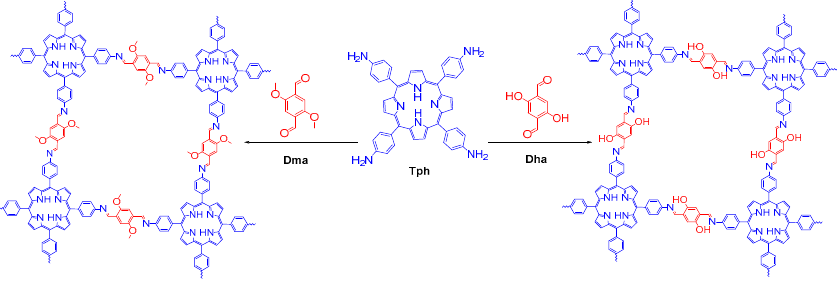
Figure 11. Syntheses of DmaTph and DhaTph by the condensation of square planar Tph building unit (blue) and linear Dma/Dha building unit (red). The introducing of -OH to the Schiff base [-C=N] centers in COFs can create an intramolecular [O-H···N=C] hydrogen bond to enhance both the chemical stability and crystallinity of COFs.